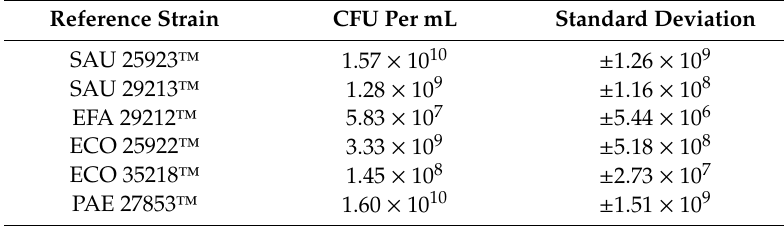
Table A1. Juxtaposition of 0.5 McFarland standard with CFU per mL for reference